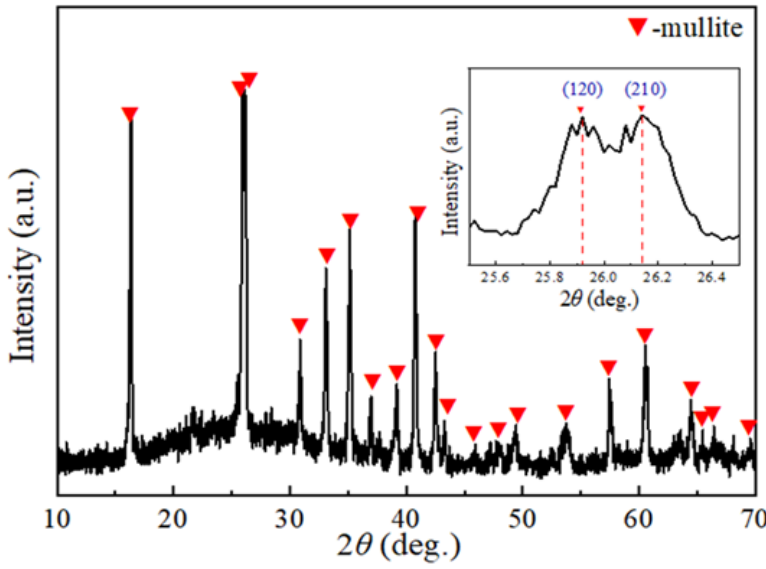
Figure 8. XRD pattern of as ‐ sprayed mullite coating.